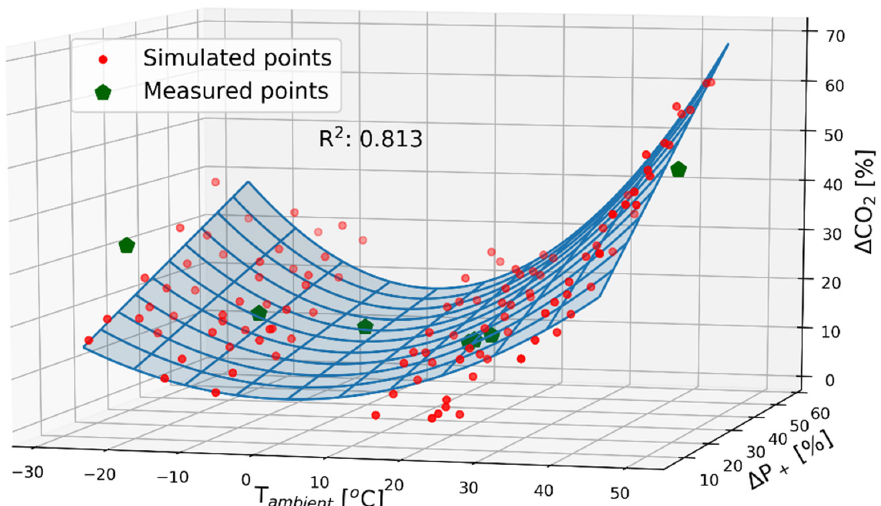
Figure 10. Red points are the simulated RDE trip CO 2 percentage difference from WLTC ( ∆ CO 2 ) in function of the mean trip ambient temperature (T amb ) and the mean positive motive power percentage difference from WLTC ( ∆ P + ) resulted from road slope change. The green points are the experimental data. The blue surface corresponds to the fit of the points: linear on the mean positive power difference, second order on the ambient temperature (Equation (9)).